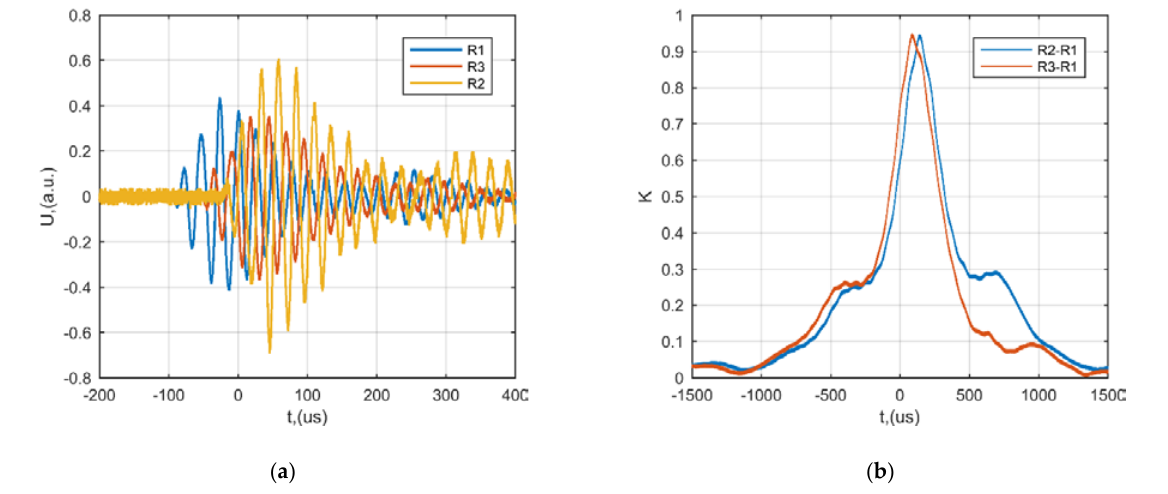
Figure 10. The example of the waveforms and cross-correlation between neighboring channels in case the source S is located straight in the observation point 8 m away along the y axis: ( a ) example of waveforms received by R 1 , R 2 , R 3 sensors, ( b ) correlation between signals in case of receiver pairs R 2 − R 1 (blue) and receiver pairs R 3 − R 1